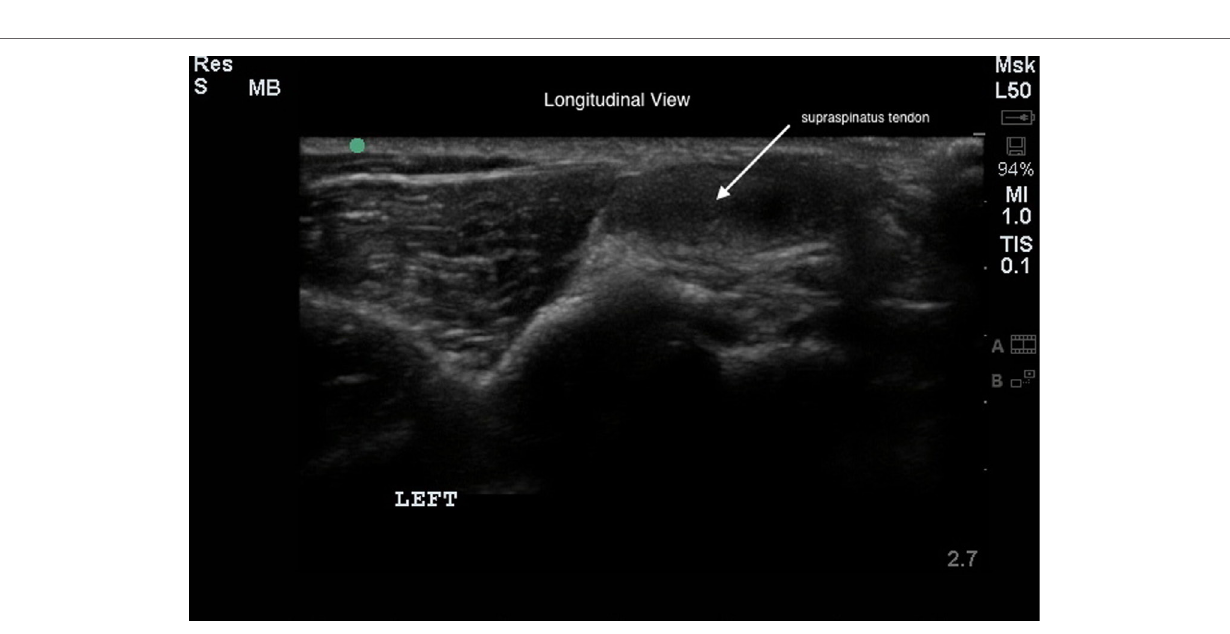
FigUre 2 | The longitudinal diagnostic musculoskeletal ultrasound image of the supraspinatus tendon (white arrow) .